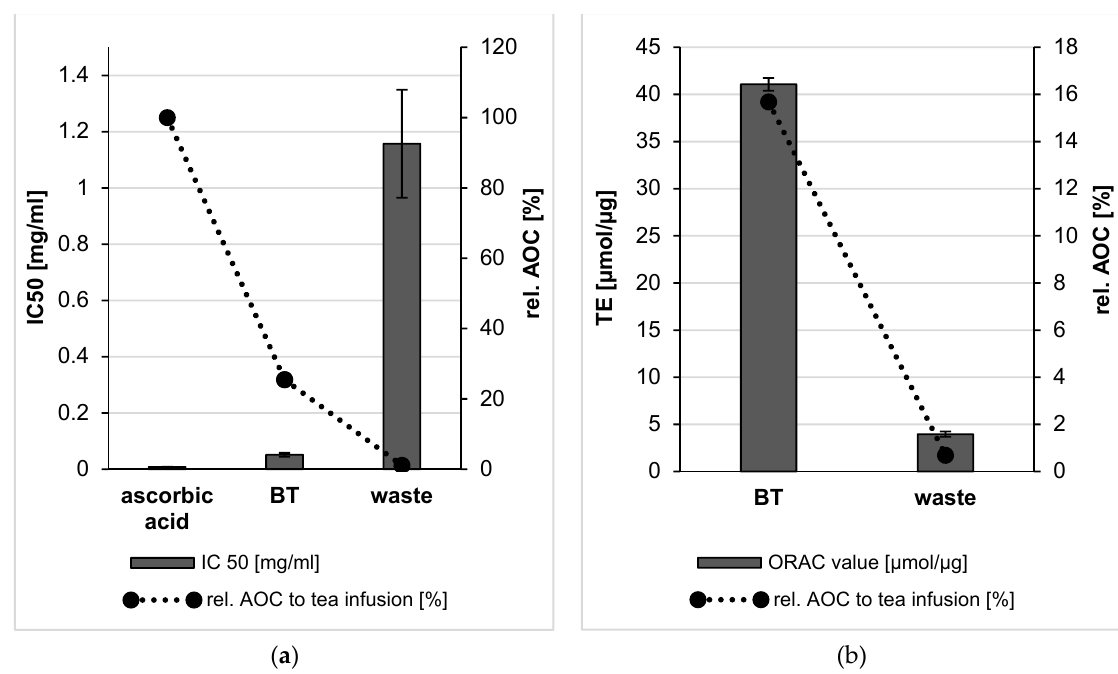
Figure 6. Antioxidant capacity of BT leaves and their waste bulk suspensions using DPPH and ORAC assays. The results of the DPPH assay were expressed as IC 50 and compared to the used standard in this study (ascorbic acid) ( a ). ORAC values were expressed as µmol Trolox equivalent per µg of the sample analyzed ( b ).